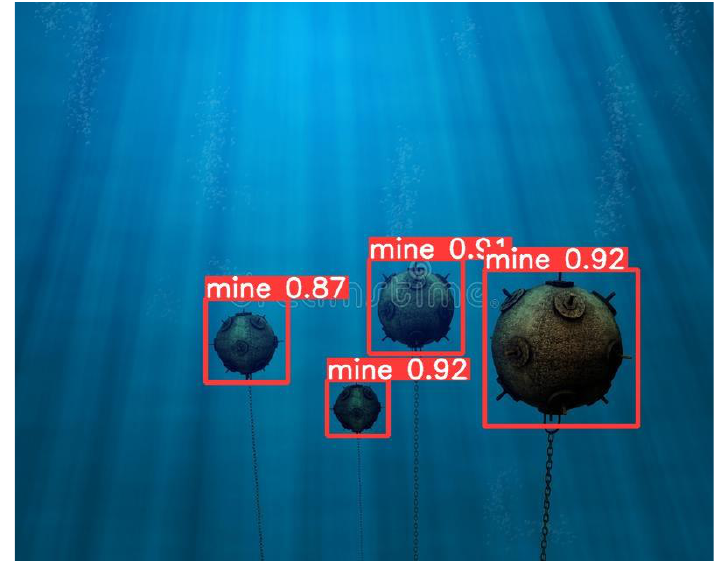
Figure 15. Underwater mine detection — model YOLOv5.